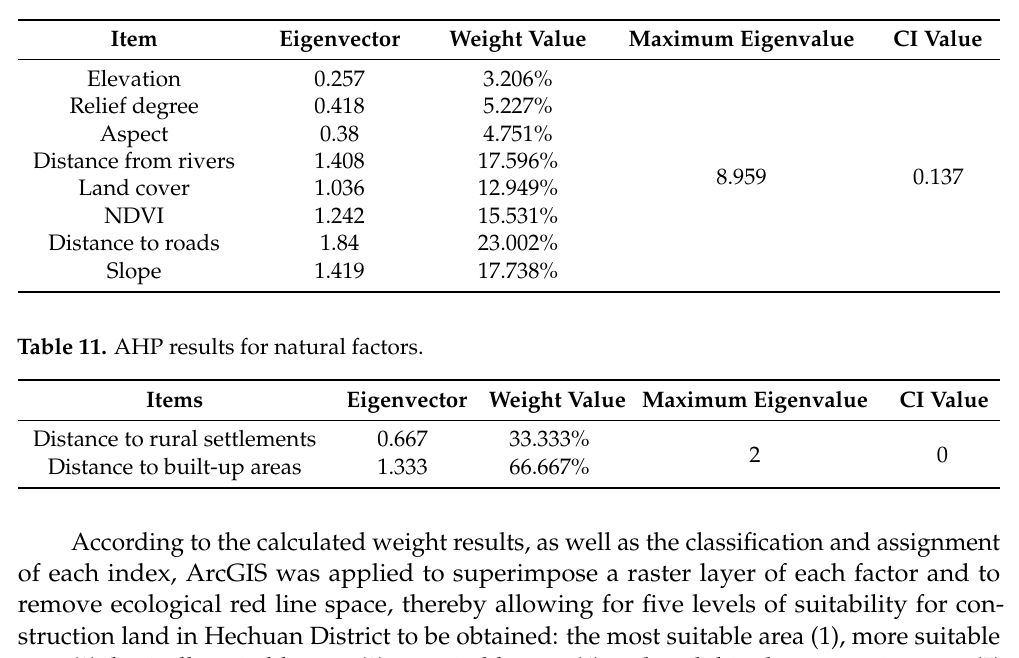
Table 10. AHP results for social factors.